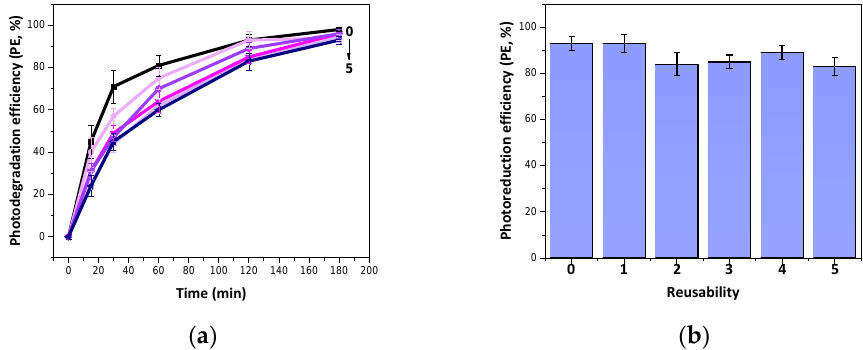
Figure 7. Stability tests ( a,b ) performed for TiO 2 @Cu(II)Pp catalyst after (0) the fresh preparation, (1) one, (2) two, (3) three (4) four, and (5) five